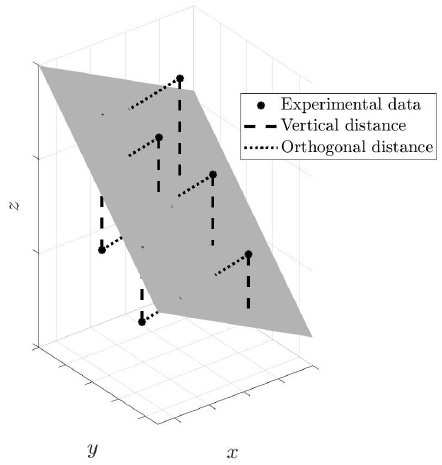
Figure 2. Approximation